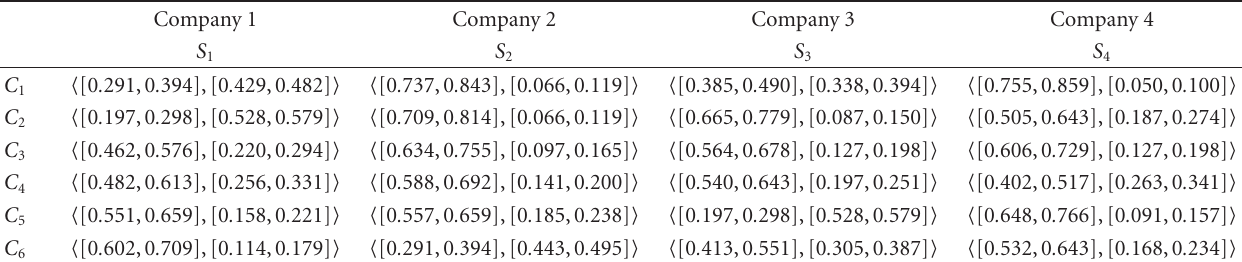
Table 9: Ideal matrix.